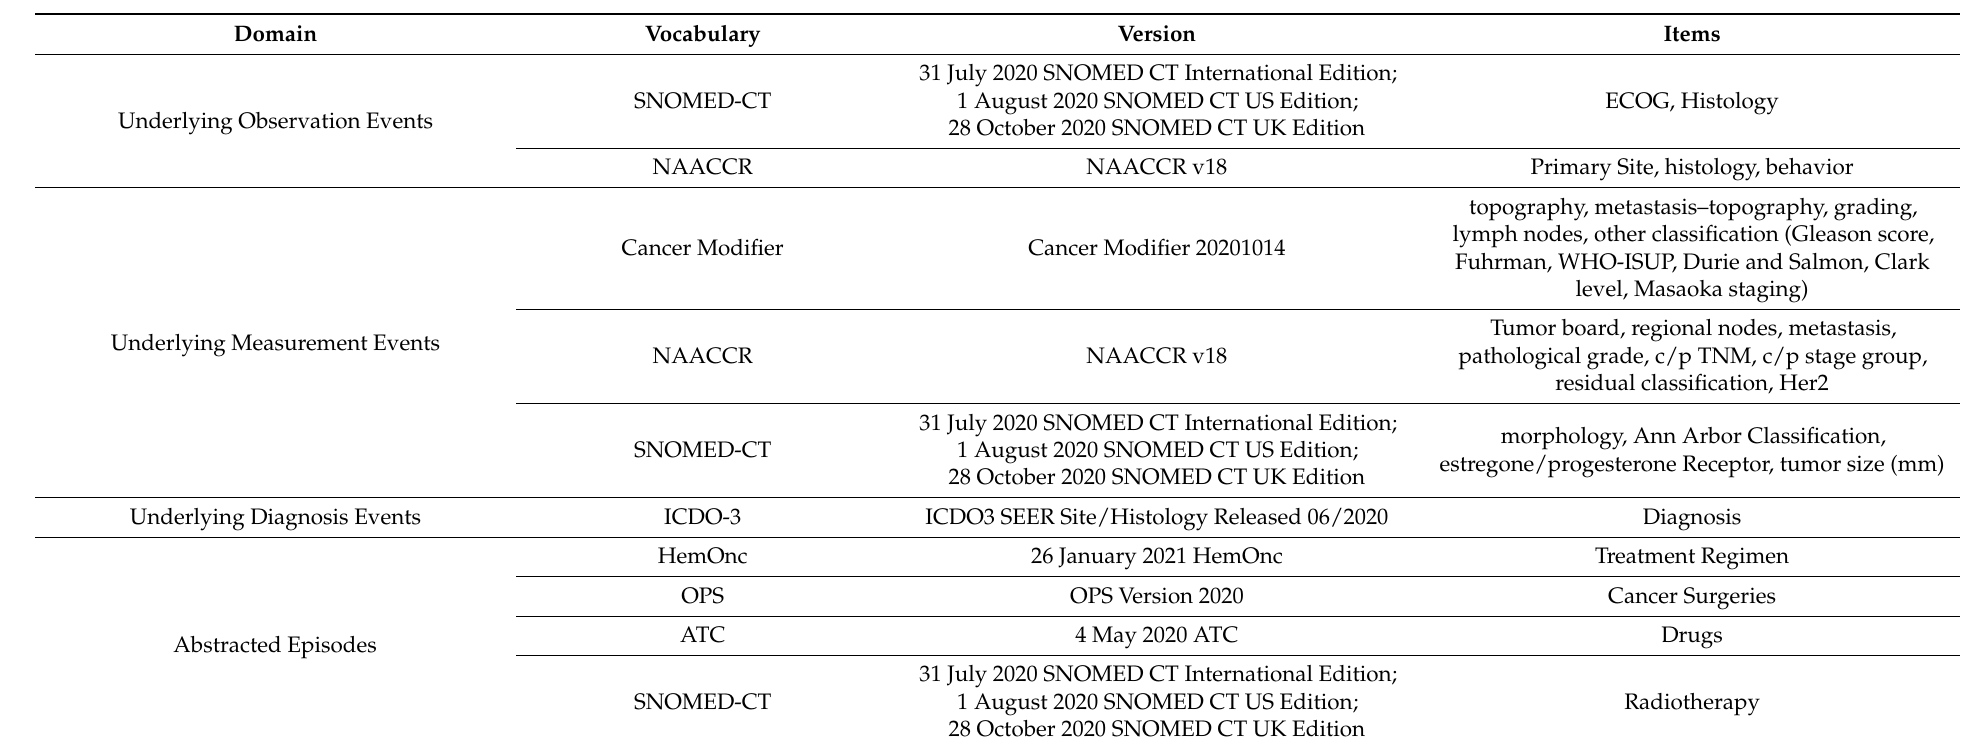
Table 1. Mapped Items by Domain and